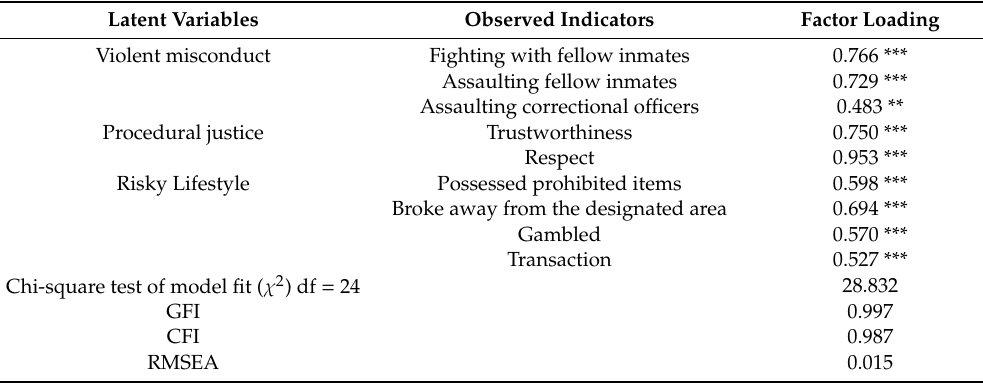
Table 2. The factor loadings of the measurement